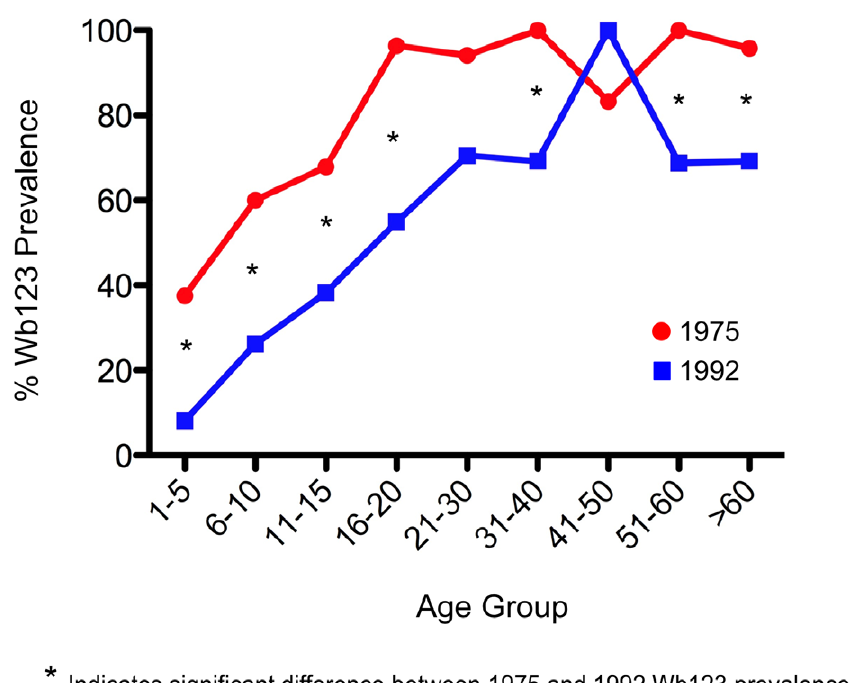
Figure 2. Prevalence of Ab to Wb123 in CAg 2 individuals. Percent prevalence (y-axis) of Ab to Wb123 by age group (x-axis) in CAg 2 individuals on Mauke from 1975 (red line) and 1992 (blue line). Asterisks represent a significant difference (p # 0.04; Fisher’s exact test) between the prevelances in 1975 and 1992 within a given age group.